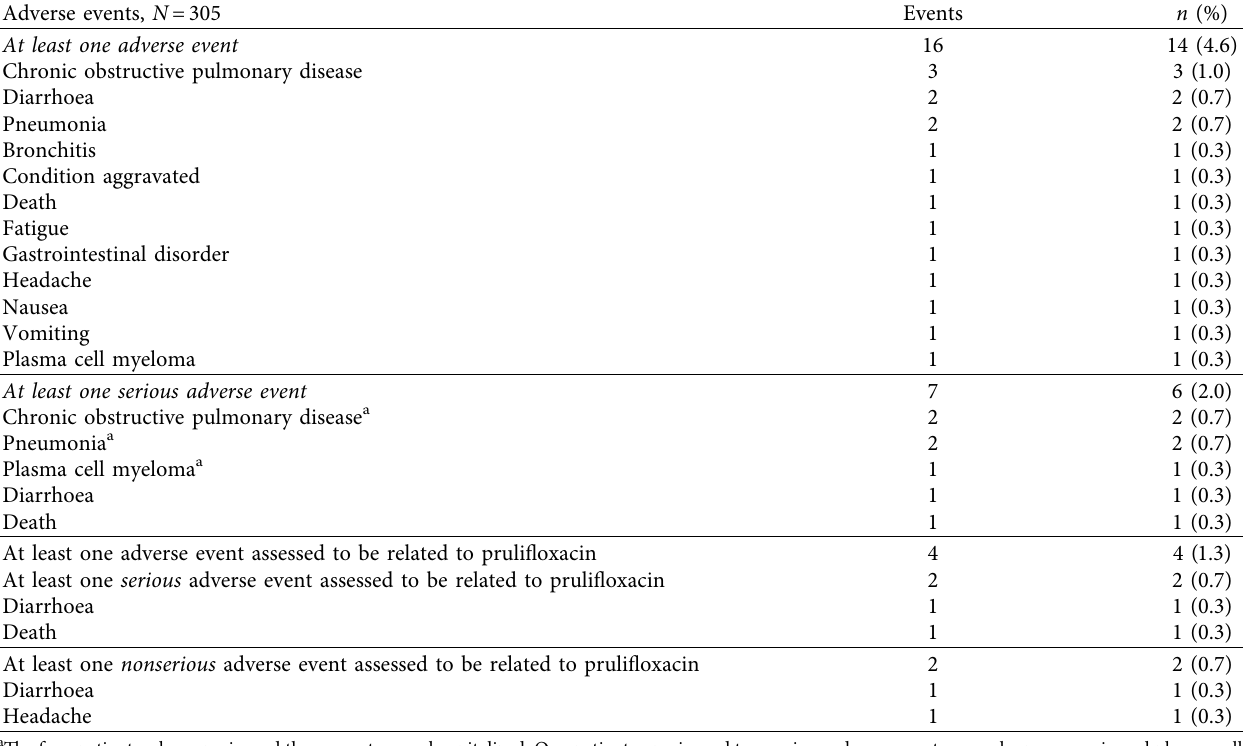
Table 3: Incidence of adverse